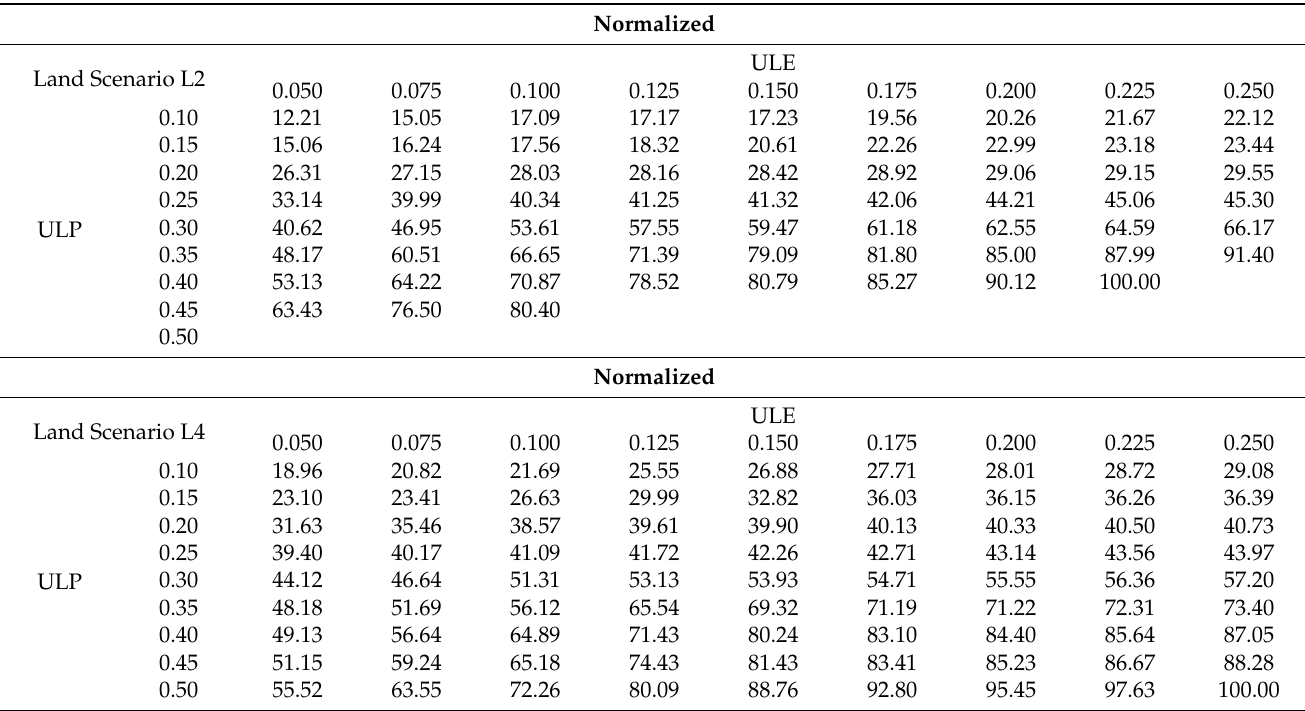
Table 13. Minimum Commuting Costs for a 9 × 9 grid of ULP and ULE values.